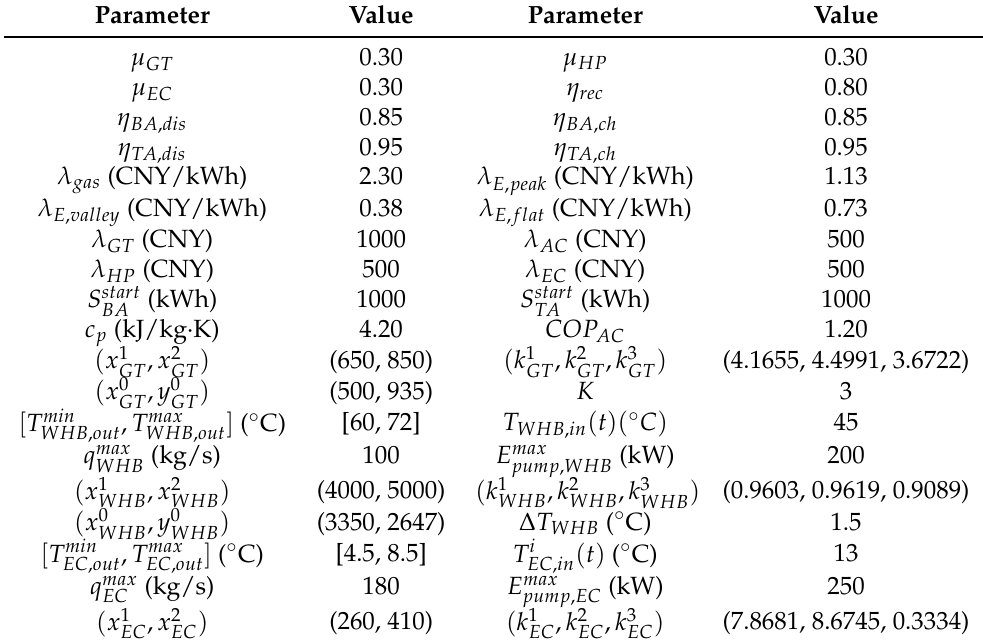
Table 3. Values of parameters in the IES in